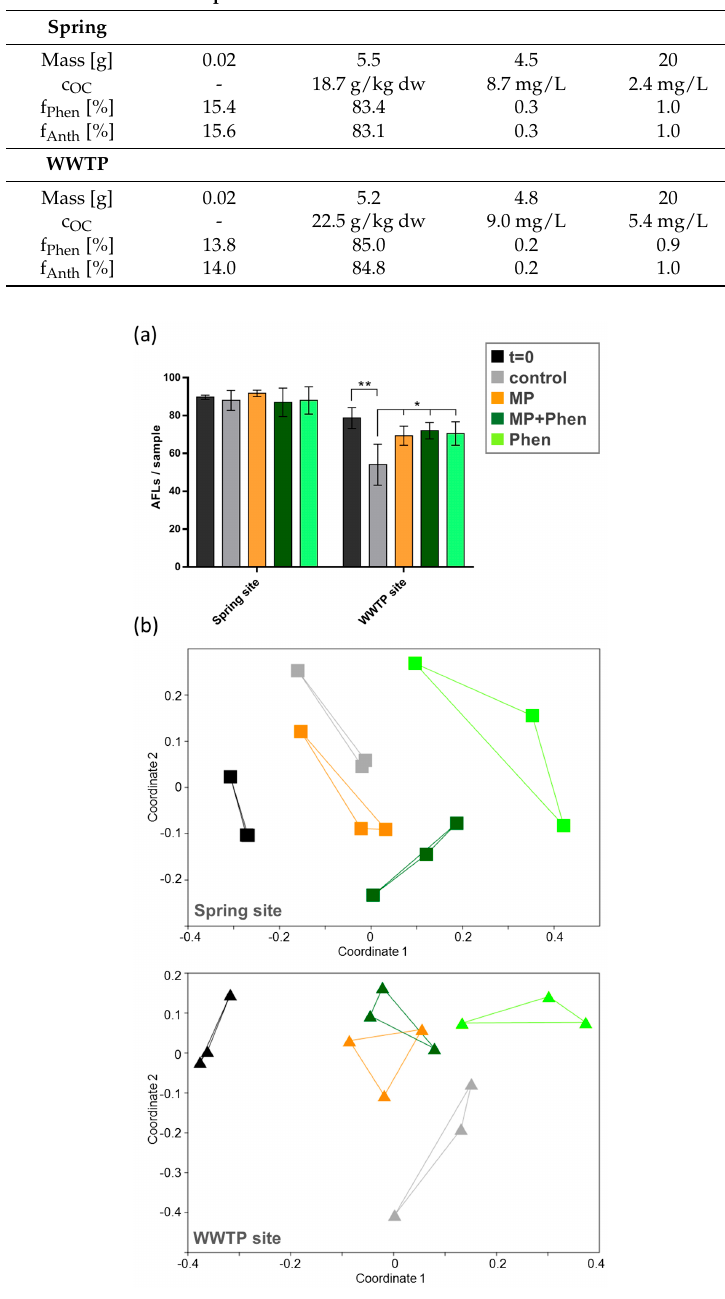
Figure 4. ( a ) Number of Automated Ribosomal Intergenic Spacer Analysis Fragment Length (AFLs) as indicator of bacterial richness in sediments from a spring site and downstream of a wastewater treatment plant (WWTP) before and after treatment with phenanthrene (Phen), polyethylene particles (MP) and phenanthrene ‐ loaded polyethylene particles (MP + Phen). Significant differences were detected with a two ‐ way ANOVA and Tukey’s multiple comparisons test (* p < 0.05, ** p < 0.01). ( b ) The data set from ( a ) is represented in an nMDS graph based on Bray ‐ Curtis similarities between samples, showing the shift in bacterial communities before and after treatment. A similar trend was observed for the sediment collected downstream of the WWTP. Here, the bacterial communities exposed to PE particles and PE particles loaded with phenanthrene clustered together (R = 0.09, ANOSIM, Tables S5 and S6), whereas the phenanthrene treatment generated a